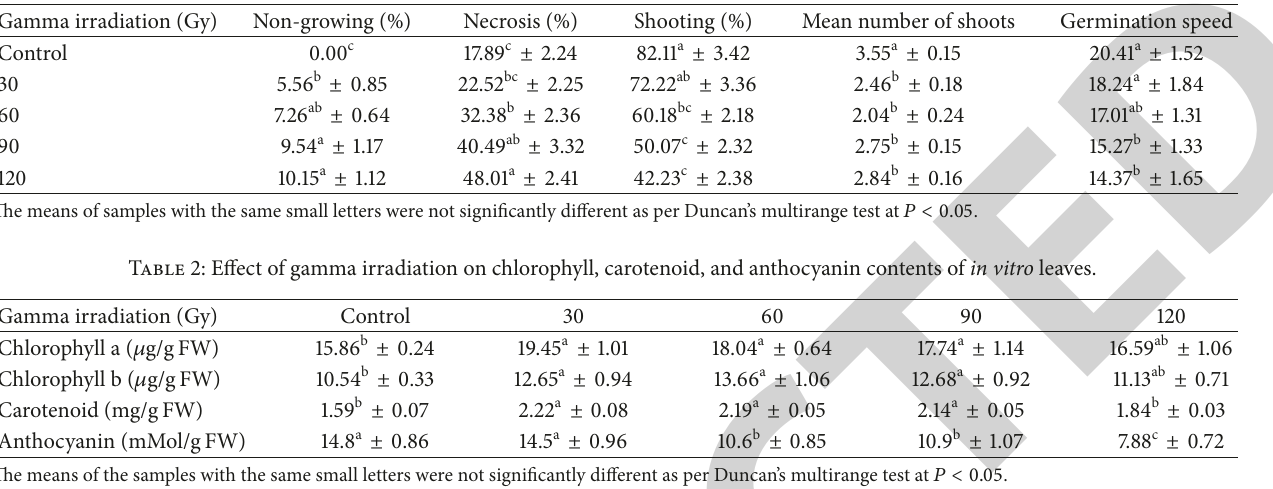
Table 1: Effect of gamma irradiation on growth stages of Onobrychis viciifolia seeds after 4 weeks.